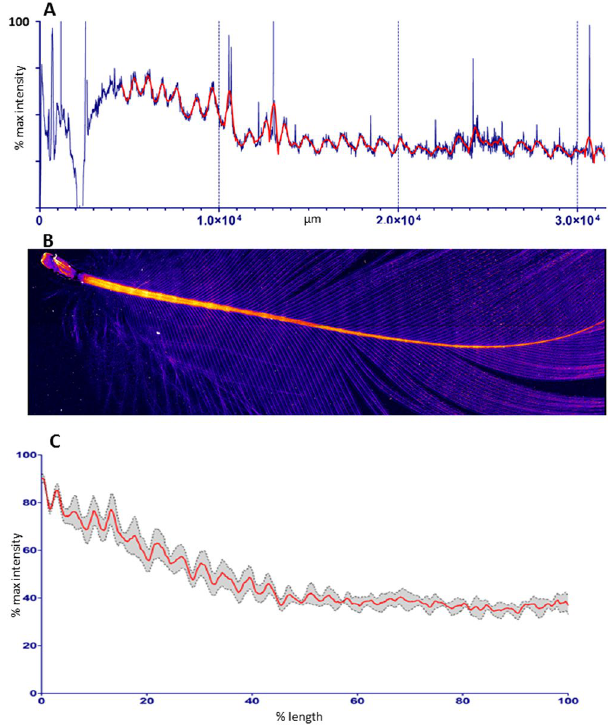
Figure 5. Zn distribution within a Flesh-footed Shearwater beast feather. The line profile ( A ) derived from the Zn map shown in ( B ) illustrates the inter-individually consistent periodicity in elemental Zn distribution. The red line shows the observed pattern after smoothing to reduce noise. The mean of Zn distributions is shown ( C ). The individual Zn distributions were taken along the rachis of each sample, normalised to length and intensity then used to create an average distribution across feather from multiple birds (n = 4) demonstrating that the number of Zn bands is consistently